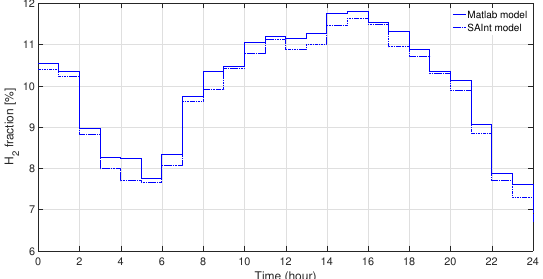
Figure A1. Hydrogen concentration variation from SAInt and Matlab